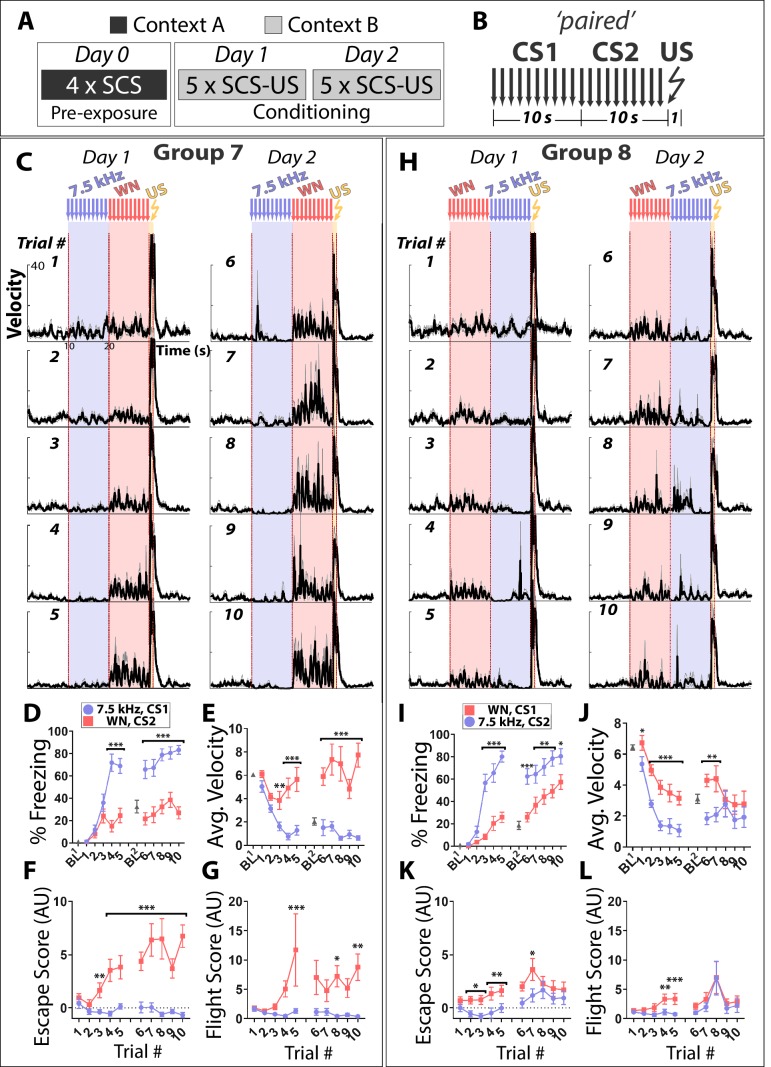
Reversing order of tone and white noise presentation during SCS conditioning does not reverse the behaviors these stimuli elicit in C57Bl6/J mice.(A,B) Protocol and structure of stimuli applied during conditioning for two paired groups. (C,H) Motion indices (mean ± SEM) showing movement in the absence or presence of stimuli (10 × 7.5 kHz pips, 75 dB, 0.5 s each at 1 Hz, blue; 10x white noise (WN) pips, 75 dB, 0.5 s each at 1 Hz, pink; 1 × 0.9 mA footshock, 1 s, yellow) for all 10 conditioning trials (Days 1 and 2) Group 7 (C) was trained with a tone-white noise SCS; Group 8 (H) was trained with a white noise-tone SCS. (D,I) Percentage time spent freezing during baseline (BL, 3 min prior to the first stimulus presented each day) and each trial (SCS presentation) across each conditioning day. (E,J) Average velocity during BL and trials. (F,K) Active fear behavior during each trial quantified by escape score (G) or flight Score (Fadok et al., 2017) (L), which yielded similar results. Both groups, n = 12 per group. Black asterisks indicate significant difference between groups for a given trial. Asterisks indicate significant difference between stimuli for a given trial. Error bars indicate SEM.Figure 1—figure supplement 2—source data 1.Raw data used to generate freezing, velocity, escape score, and flight score plots and traces.Figure 1—figure supplement 2—source data 2.All statistical tests and significant comparisons with F and P values.